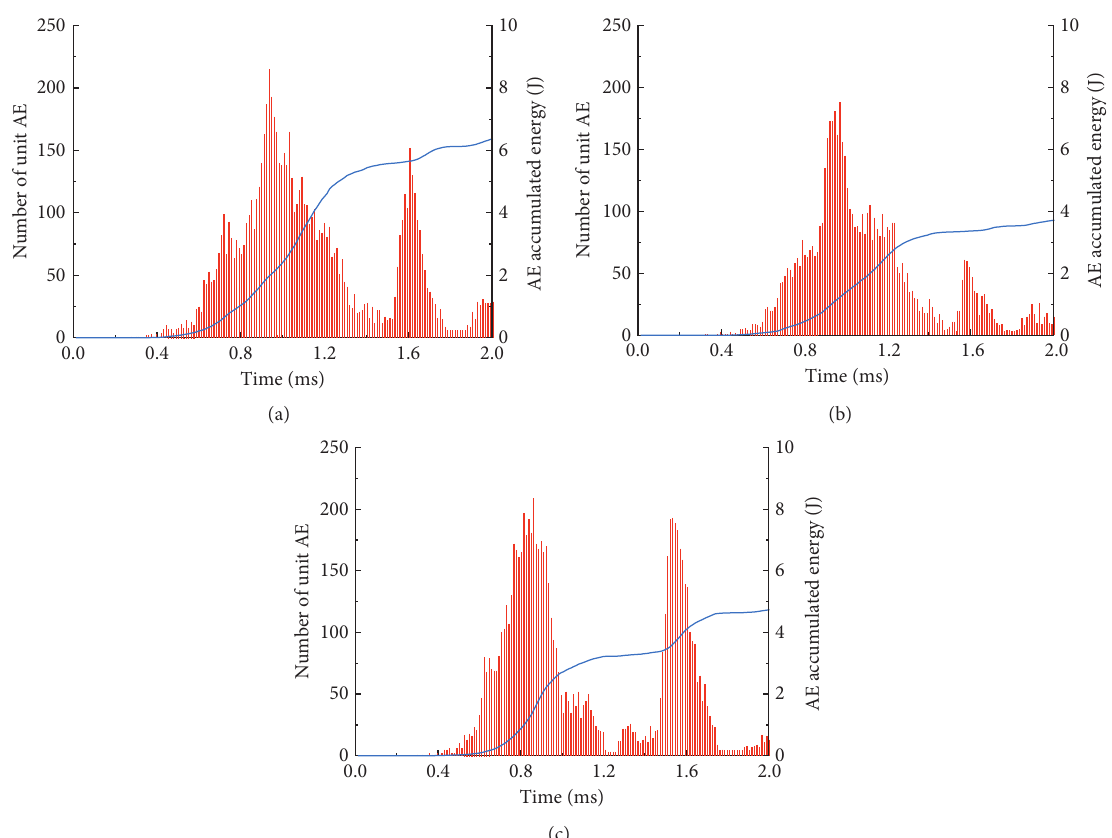
Figure 12: Number of unit acoustic emissions and energy characteristics of the numerical models under dynamic load. (a) Model I; (b) model II; and (c) model